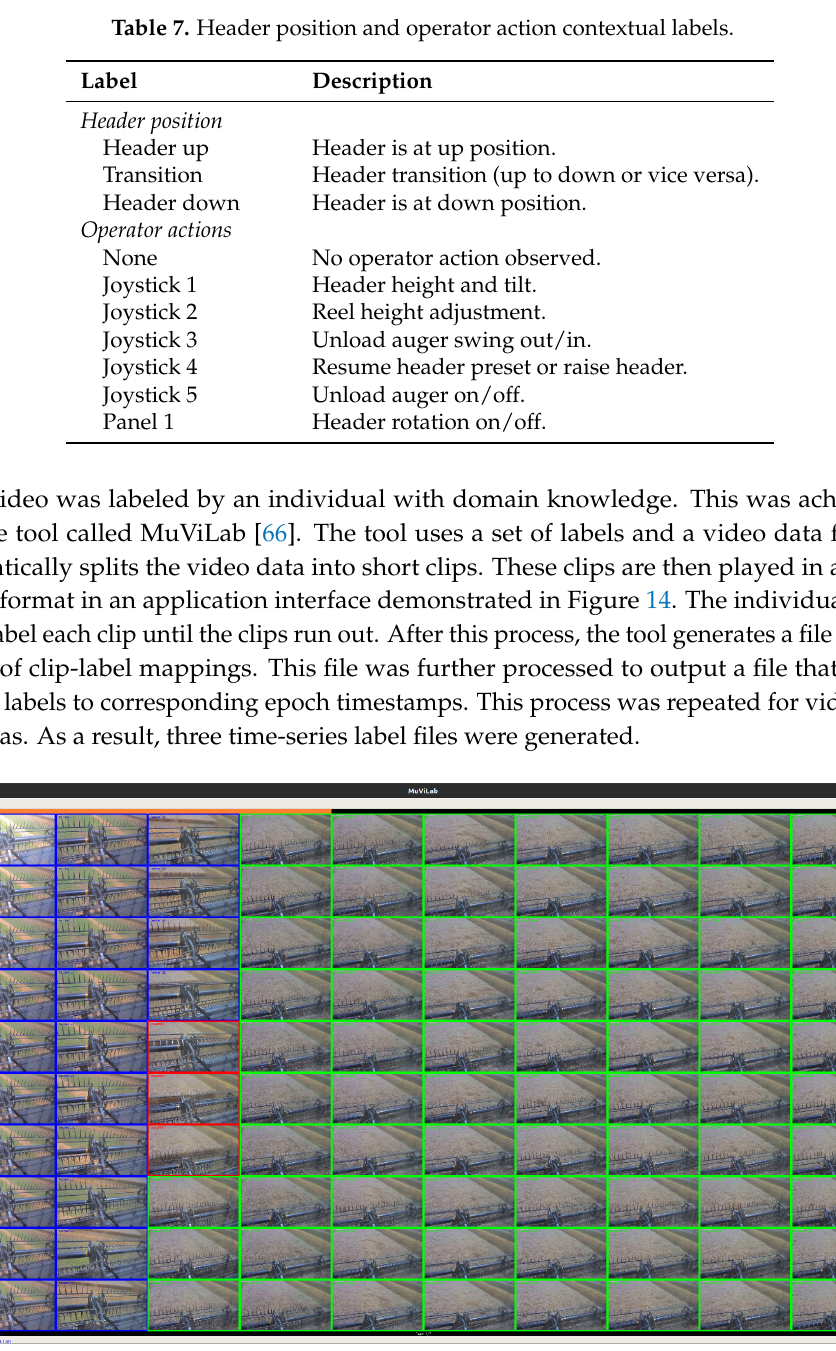
Figure 14. MuViLab, an open-source tool for simultaneously labeling multiple frames of a video, was utilized for labeling videos with contextual labels. In this screenshot of the tool interface, blue, red, green boxes each stand for “header up”, “transition”, and “header down”